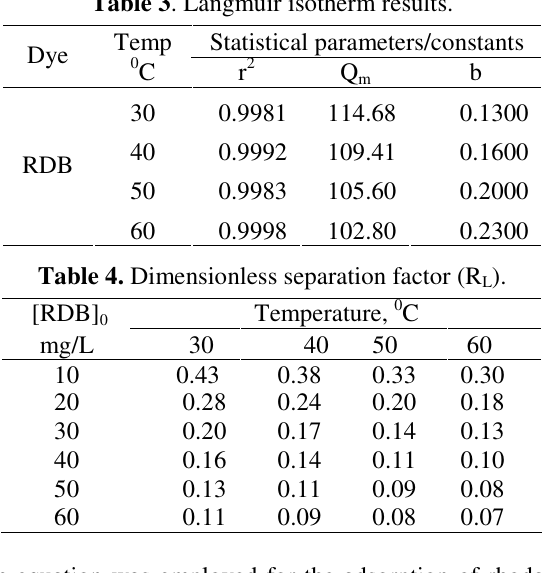
Table 3 . Langmuir isotherm results.